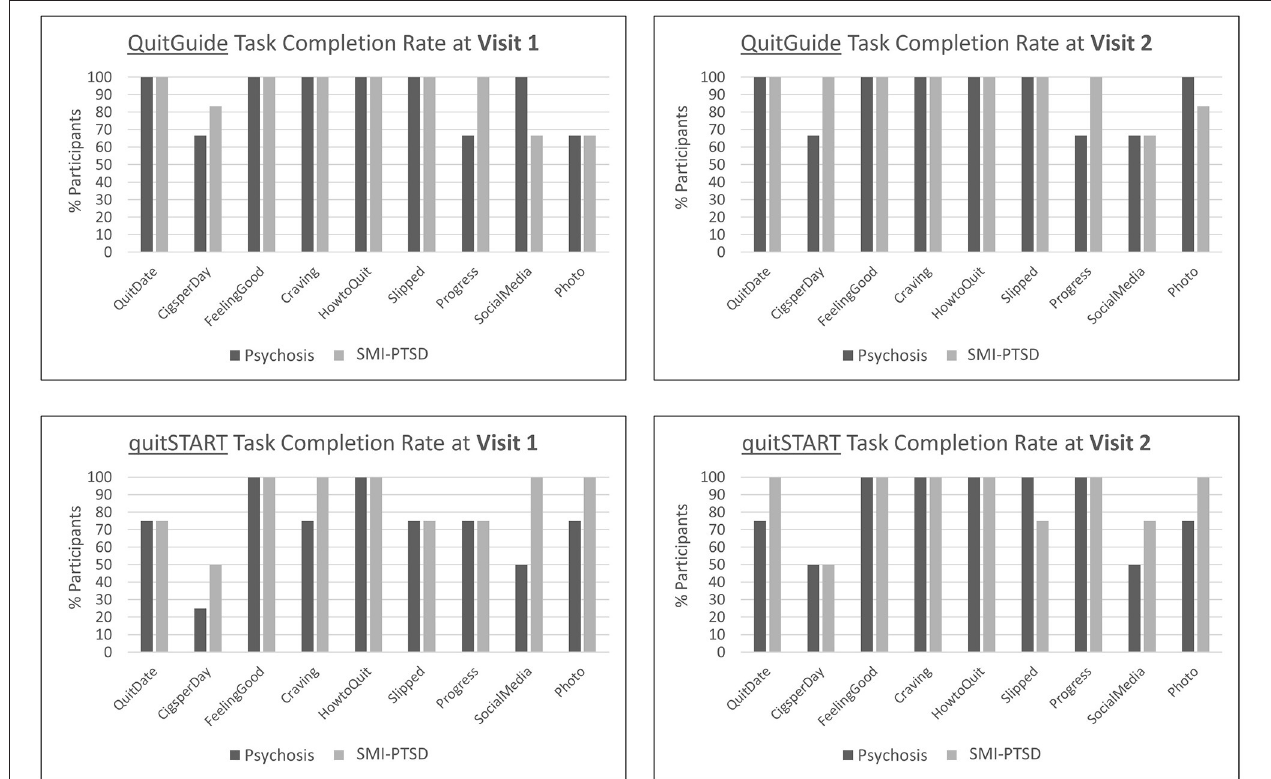
FIGURE 2 | Task completion rates for each app for participants with psychosis and